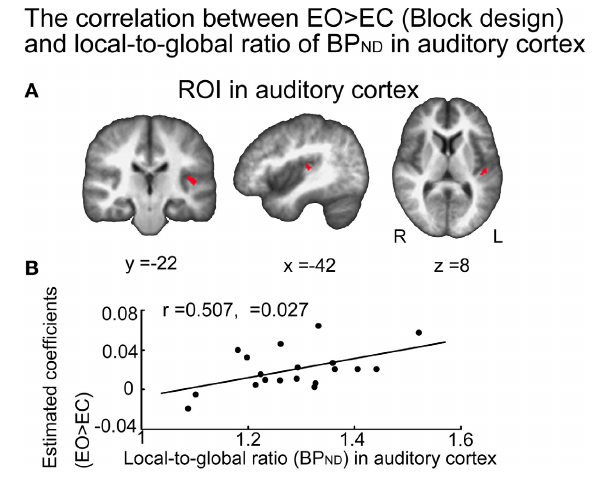
FIGURE A2 | The correlation between the estimated coefficients (EO > EC) and the local-to-global ratio of GABA A receptor BP ND (white matter as reference region) in the left auditory cortex. (A) Activated regions in the left auditory cortex that are taken as the ROI. (B) Positive correlation between the estimated coefficient of the contrast EO > EC and the local-to-global ratio of GABA A receptor BP ND in the left auditory cortex ( n = 19) ( r = 0 . 507, p = 0 . 027 uncorrected).